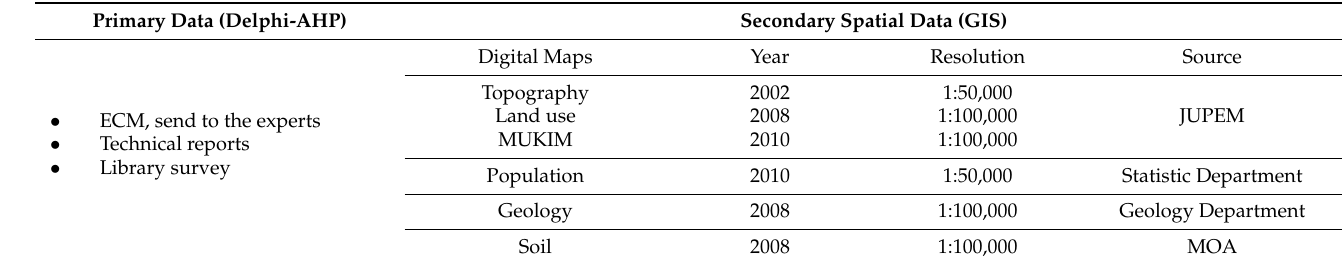
Table 1. Primary and Secondary